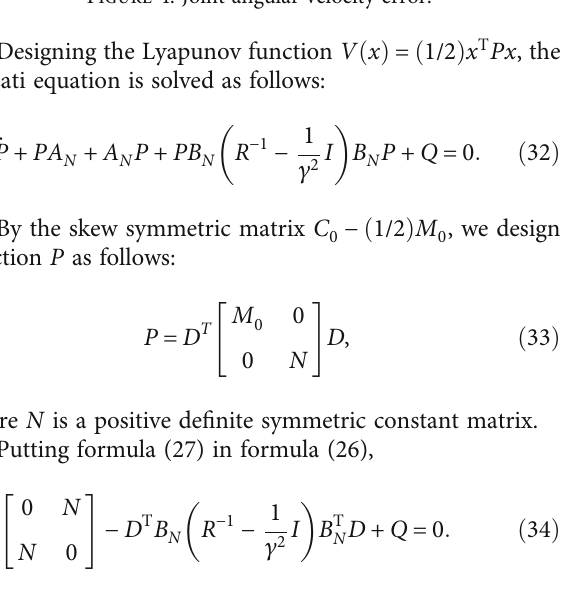
Figure 6: Substrate